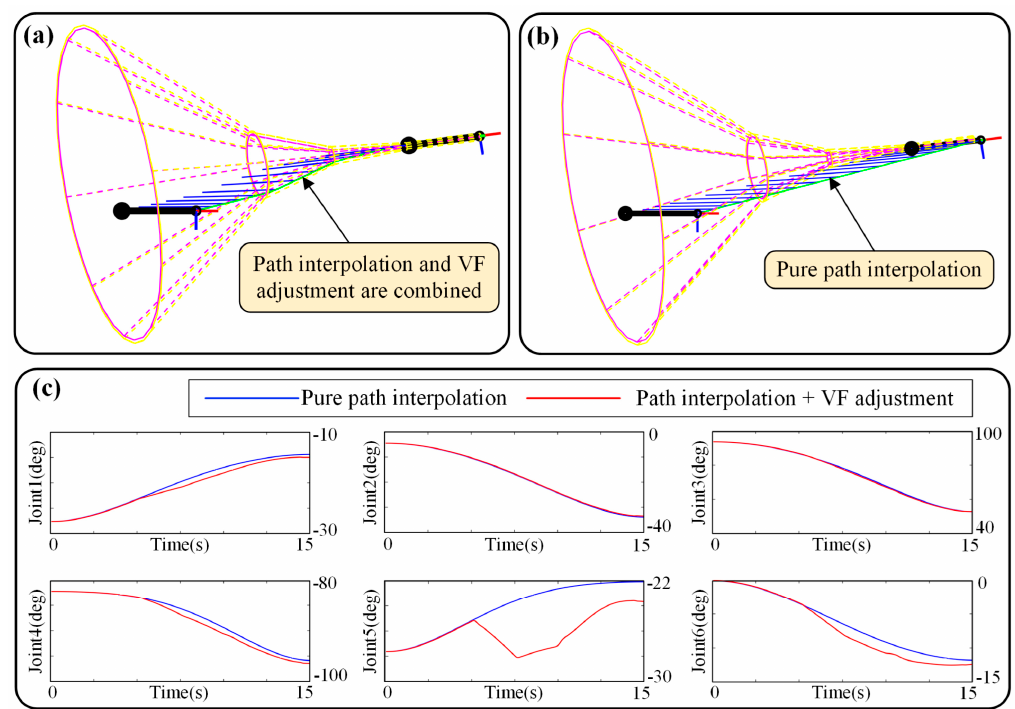
Figure 17. Simulation of “static and automatic” feeding: ( a ) Motion process when path interpolation and VF adjustment are combined; ( b ) Motion process when VF is deactivated, which is pure path interpolation, and the VF is exceed; ( c ) Angle–time curves of joint space.